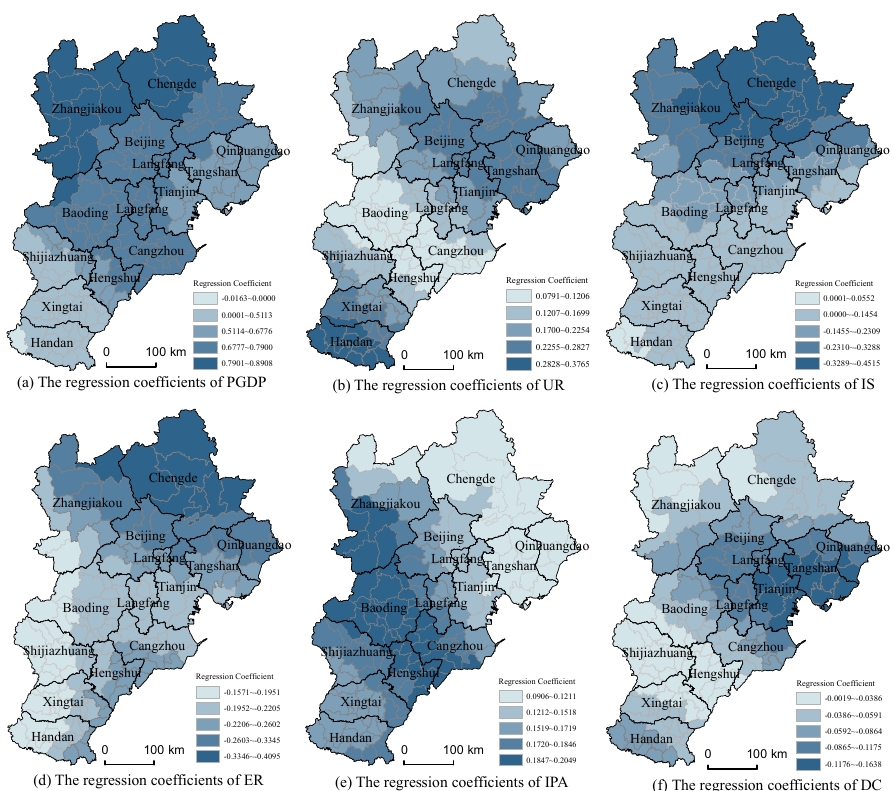
Figure 6. Spatial distribution graph of the regression coefficients of driving factors for COD.